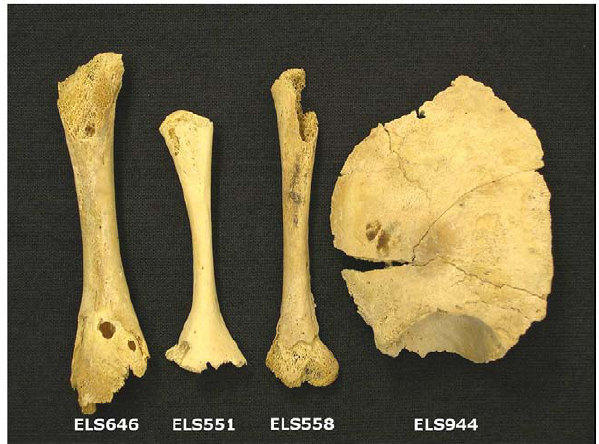
Figure 1. The presence of two left humeri (ELS 551 and ELS 558) indicates that at least two individuals are represented in these remains. Molecular data confirmed the presence of at least two individuals, one that might be represented by ELS 551, ELS646, and ELS 944, and one represented by ELS558 (see results). doi:10.1371/journal.pone.0036371.g001 PLoS ONE |